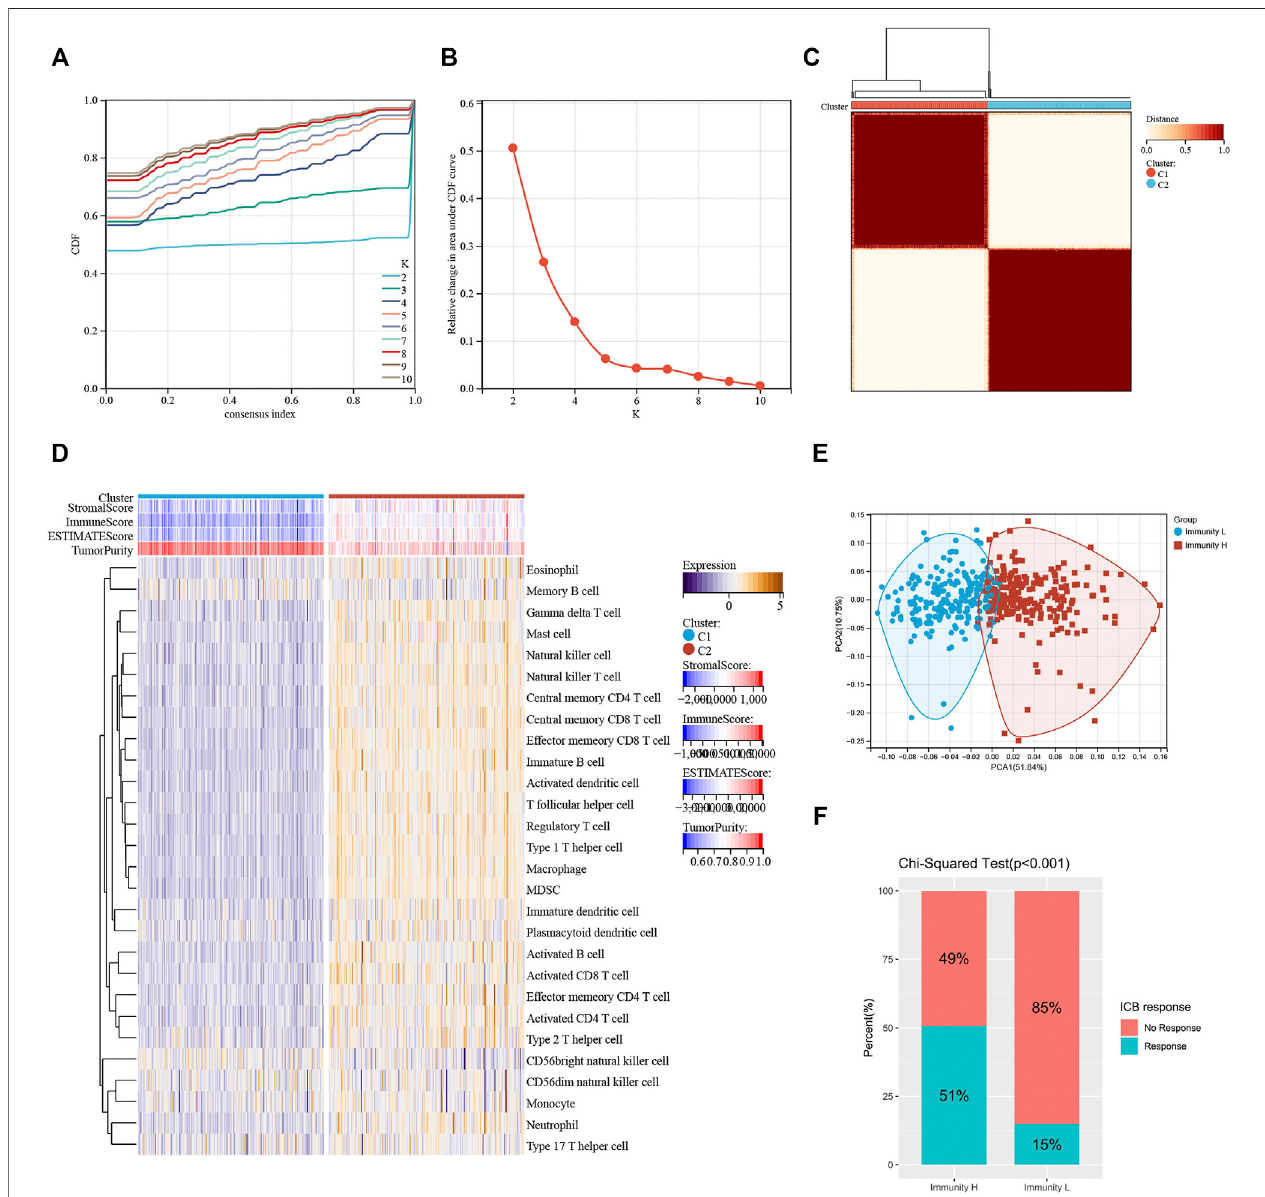
FIGURE 2 | Two patterns of colon cancer based on immune cell clustering. (A) Cumulative distribution function (CDF) under different clustering numbers. (B) Relative change in area under CDF curve with different clustering numbers. (C) Clustering heatmap when k = 2. (D) Heatmap showing the differences in immune cell ssGSEAscoresbetweentwoclusters. (E) PCAregardingtwoclusters. (F) Thedifferencesinresponseratestoimmunecheckpointblockadesbetweentwoclusters. (G) The expressions of HLA genes between two